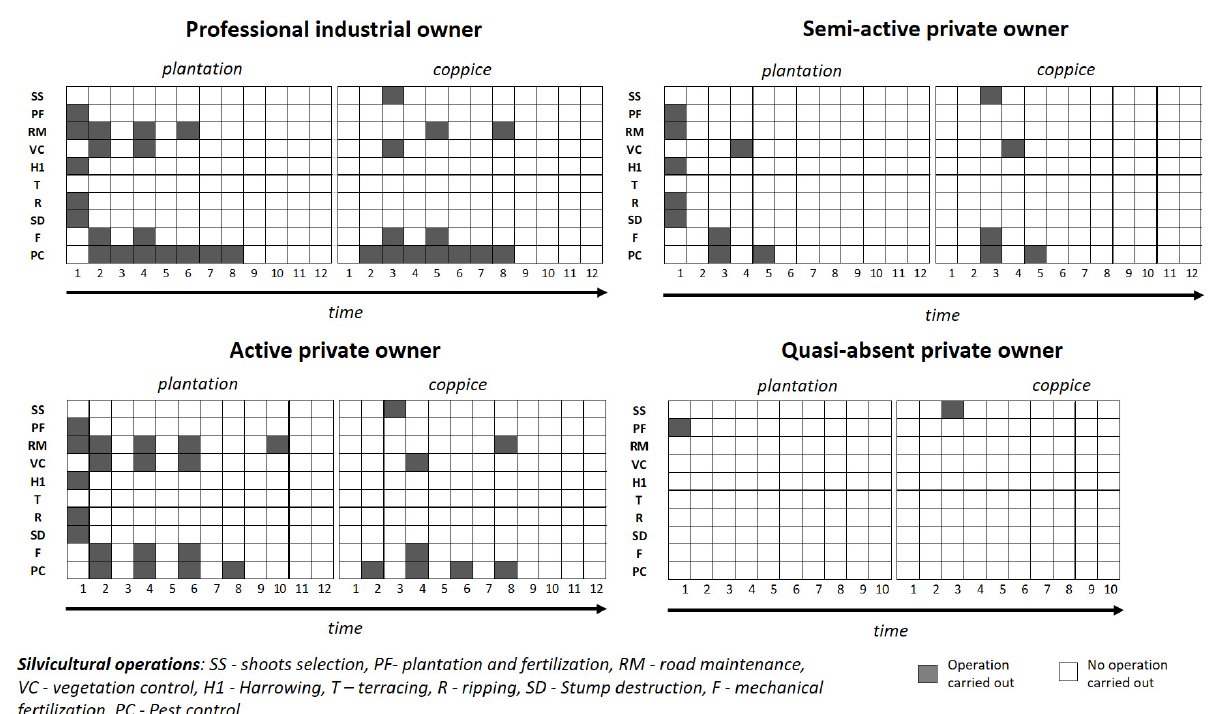
Figure 1. Illustration of the management intensity for the FMA corresponding to each owner type (without detailing the “FMA variants” considered), with the dark gray cells representing the frequency and timing of silvicultural operations.